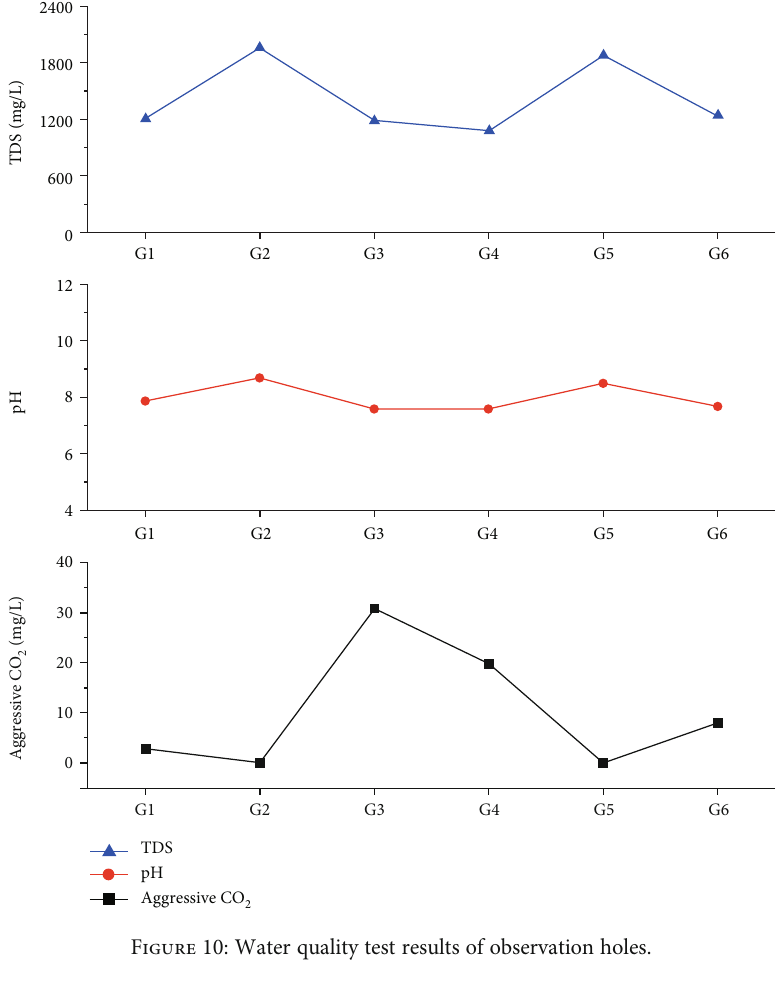
Figure 10: Water quality test results of observation holes.